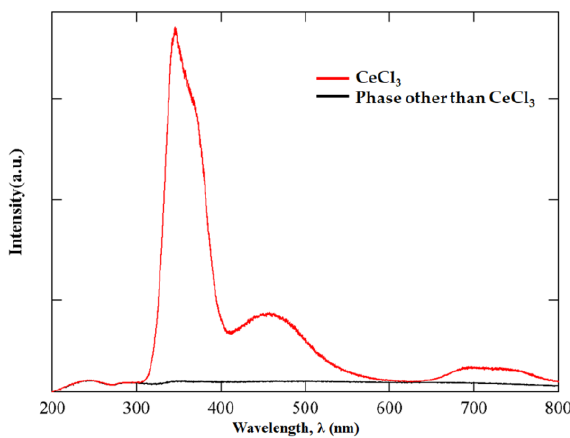
Figure 6. CL spectra on each crystal phase in the eutectic sample.